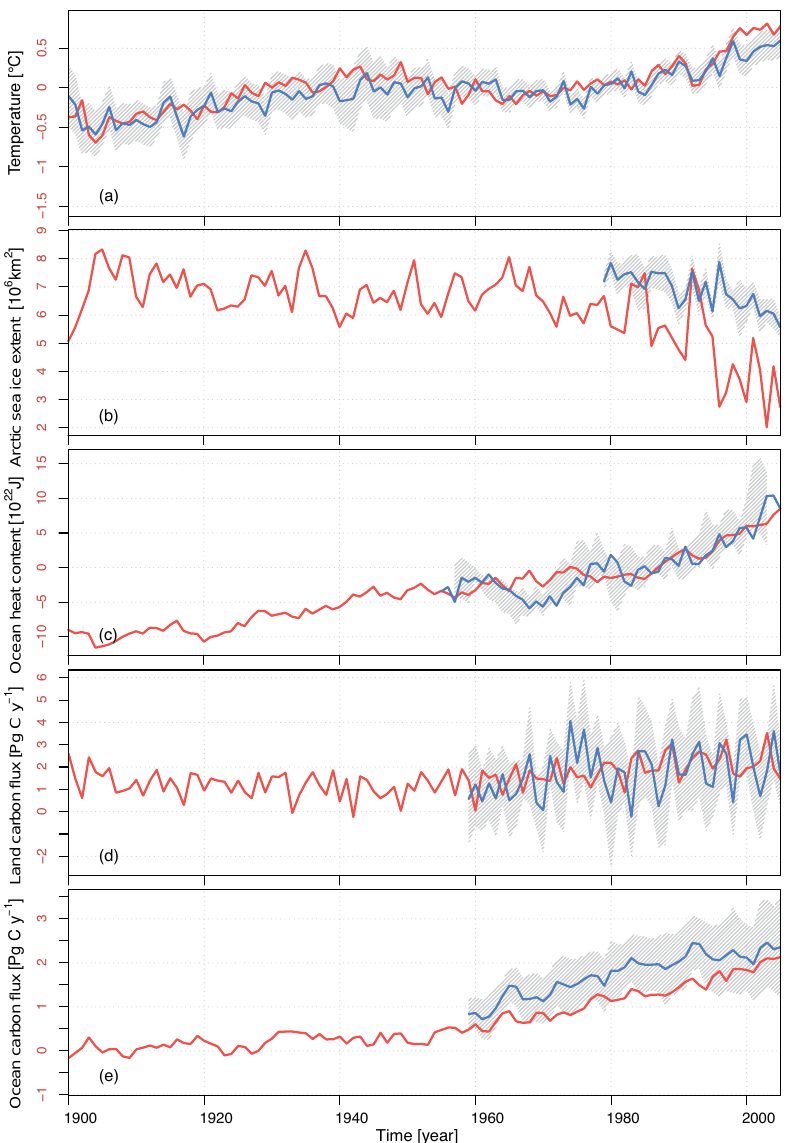
Figure 19. Time series of various climate indices as monitored from available observations (blue solid line) and as simulated by CNRM- ESM1 (red solid line) since 1901 with global near-surface temperature (a) , September Arctic sea-ice extent (b) , 0–2000m ocean heat content (c) , land carbon flux (d) and ocean carbon flux (e) . Hatching represents the ± 2 σ estimated from the ensemble deviation between the 100 members of the HadCRUT4 database (Morice et al., 2012) for near-surface temperature, the standard deviation between two National Snow and Ice Data Center estimates (Fetterer et al., 2002; Comiso, 1999) and Hadisst (Rayner et al., 2003) databases, the pentadal variability of the observed ocean heat content (Levitus et al., 2012) and spread between Global Carbon Project reconstructions for both land and ocean (Le Quéré et al., 2014). For both OCS and LCS, positive (negative) fluxes indicate an uptake (outgassing) of CO 2